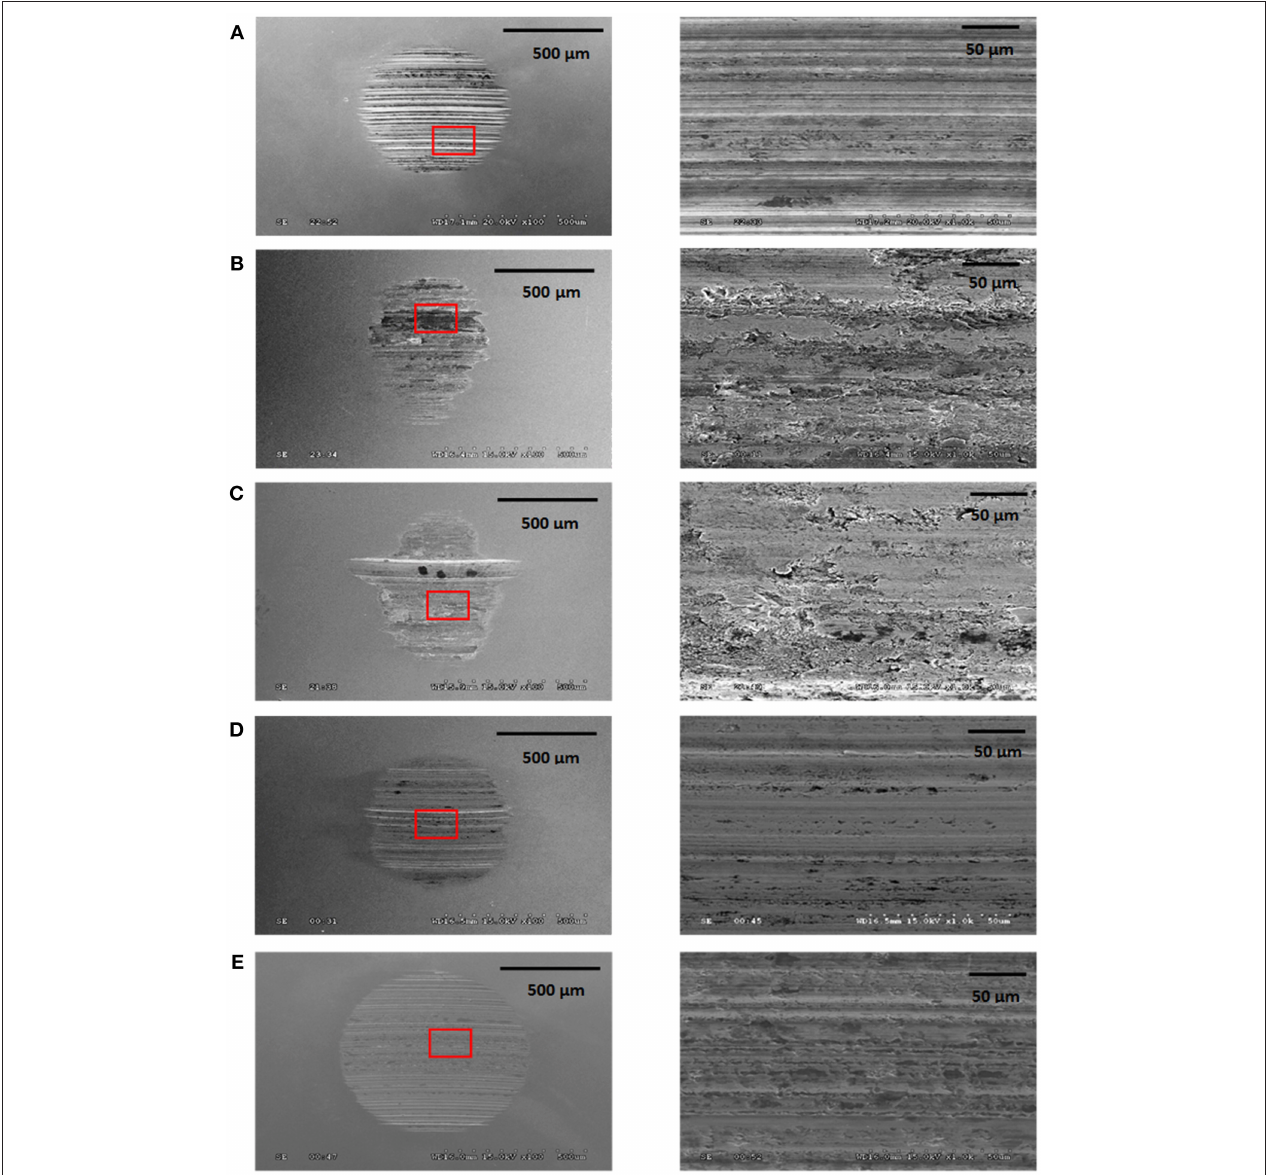
FIGURE 8 | Secondary scanning electron microscopy images of four ball wear scars at 100X and 1,000X for grease blends (A) MWCNT_P IL1 (B) MWCNT_P IL2 (C) MWCNT_N IL1 (D) MWCNT_N IL2 (E)